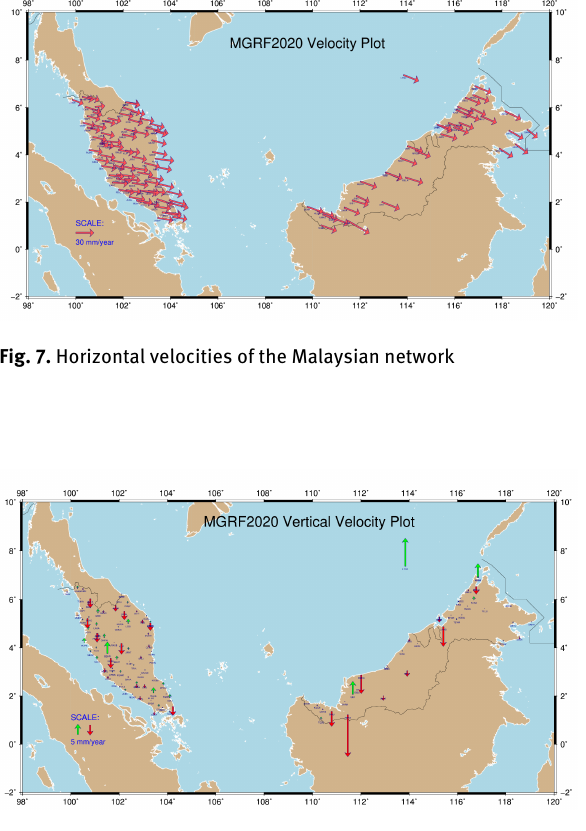
Fig. 8. Vertical velocities of the Malaysian network Figures 7 and 8 illustrate the horizontal and vertical velocity fields in IGS14 for the Malaysian CORS network at present. These were obtained from stacking all station positions time series to produce the corresponding cumu- lative solution. The plotted horizontal velocities (Fig. 7) largely resemble the absolute plate motion of the Sunda- land block. The vertical velocities (Fig. 8) can only result from either plate deformation or local effects related to ei- ther (human) induced subsidence or issues with the CORS station monument